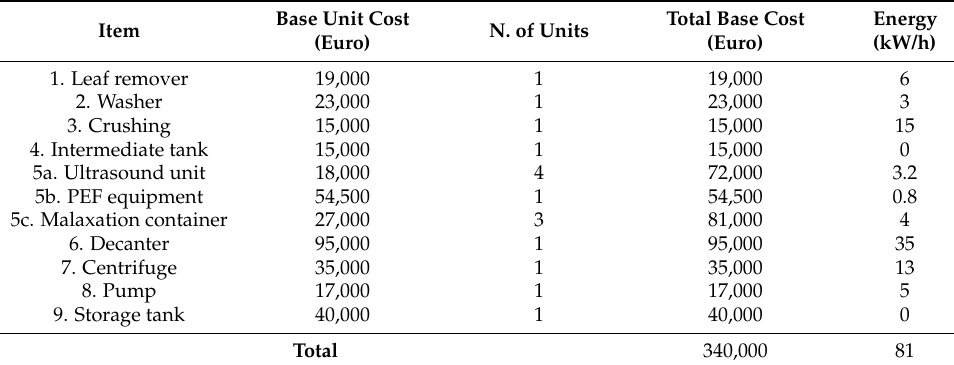
Table 3. Costs of principle equipment and energy